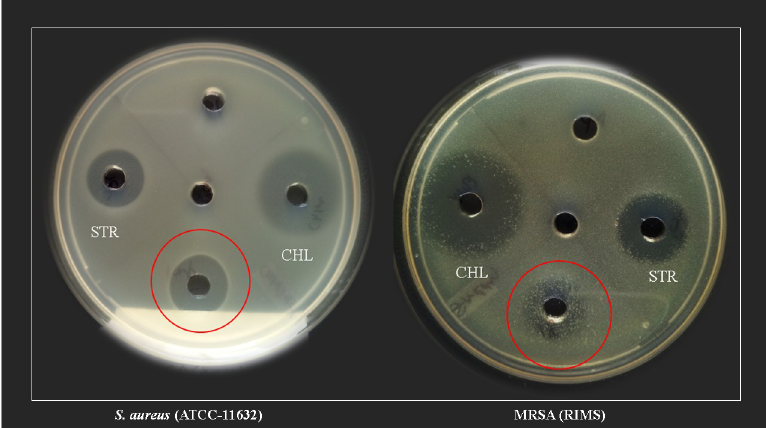
Fig 3. Antibacterial potential of ethyl acetate extract against S . aureus and MRSA (STR = streptomycin; CHL = chloramphenicol).